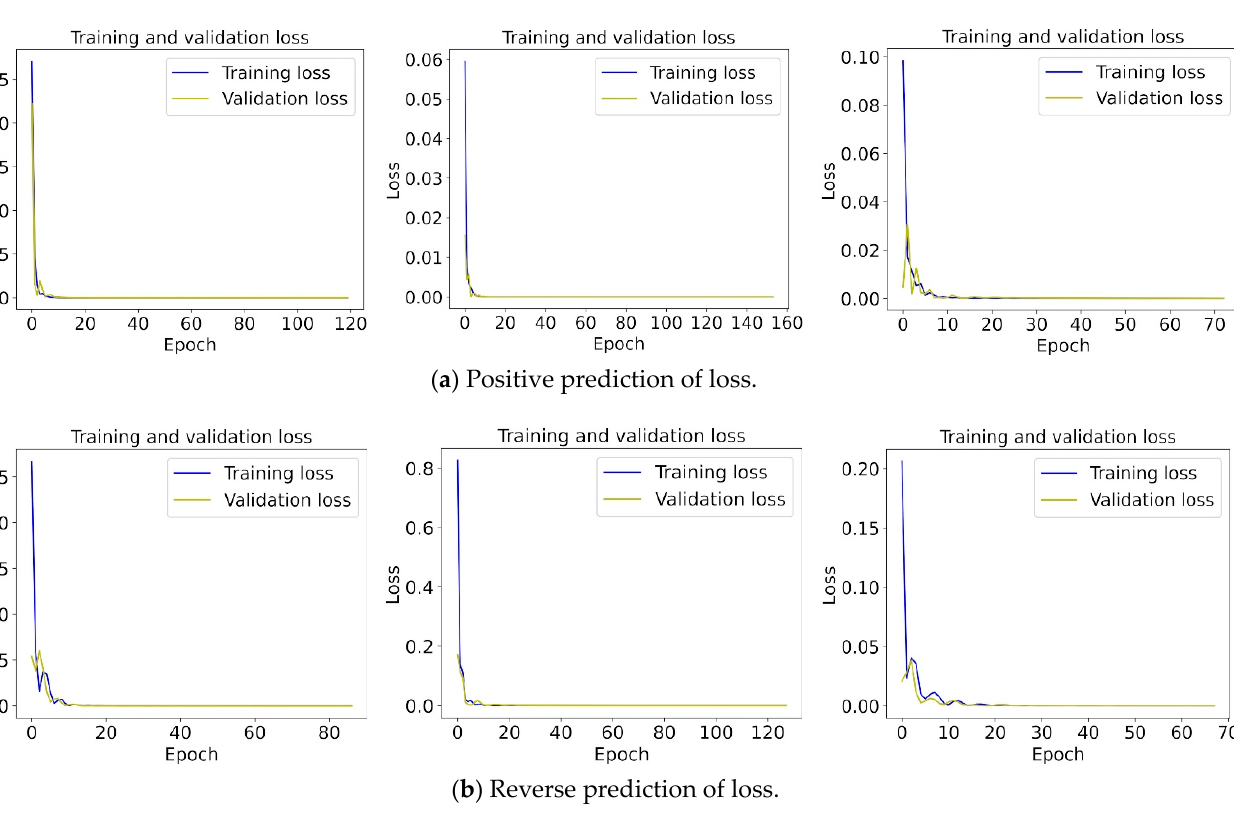
Figure 11. Training process of the proposed network. The original ship trajectory data are input to the prediction model after data segmentation and normalization. The model is trained through it- erations to output the prediction results, and the results are back-normalized to obtain the pre- dicted trajectories.